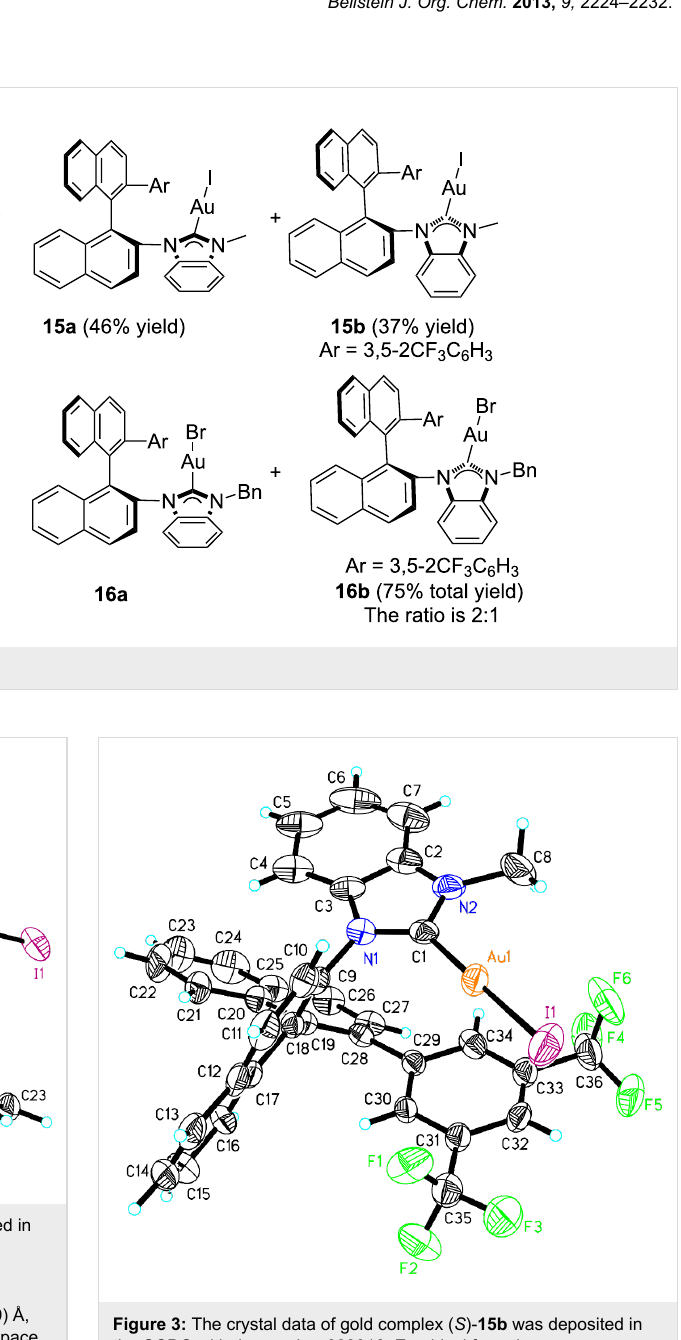
Figure 3: The crystal data of gold complex ( S )- 15b was deposited in the CCDC with the number 883916. Empirical formula: C 36 H 22 AuF 6 IN 2 ; formula weight: 920.42; crystal color, colorless; crystal dimensions: 0.265 × 0.211 × 0.147 mm; crystal system: orthorhombic; lattice parameters: a = 7.6103(5) Å, b = 12.6408(8) Å, c = 34.029(2) Å, α = 90 o , β = 90 o , γ = 90 o , V = 3273.6(4) Å 3 ; space group: P 2(1)2(1)2(1); Z = 4; D calc = 1.868 g/cm 3 ; F 000 = 1752; final R indices [I > 2sigma(I)]: R1 = 0.0482; wR2 =